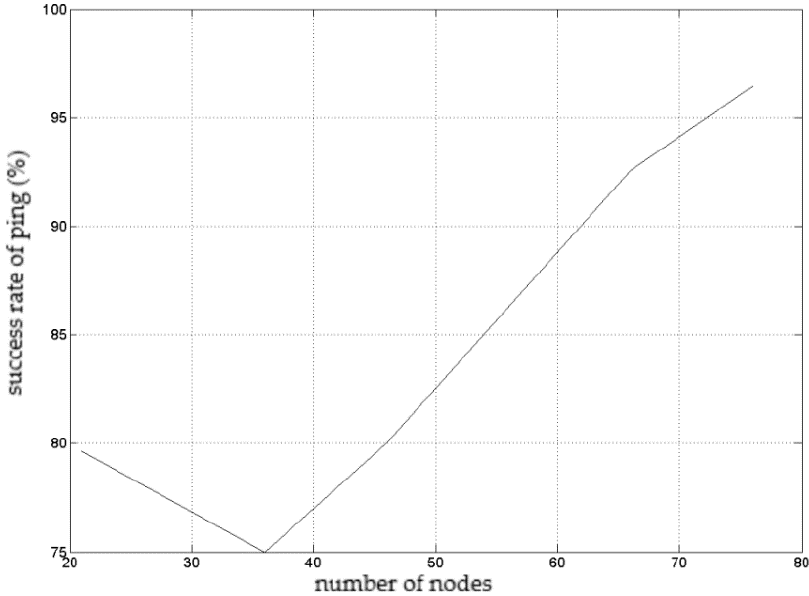
Figure 14. Ping success rate of a node when the number of nodes is different.